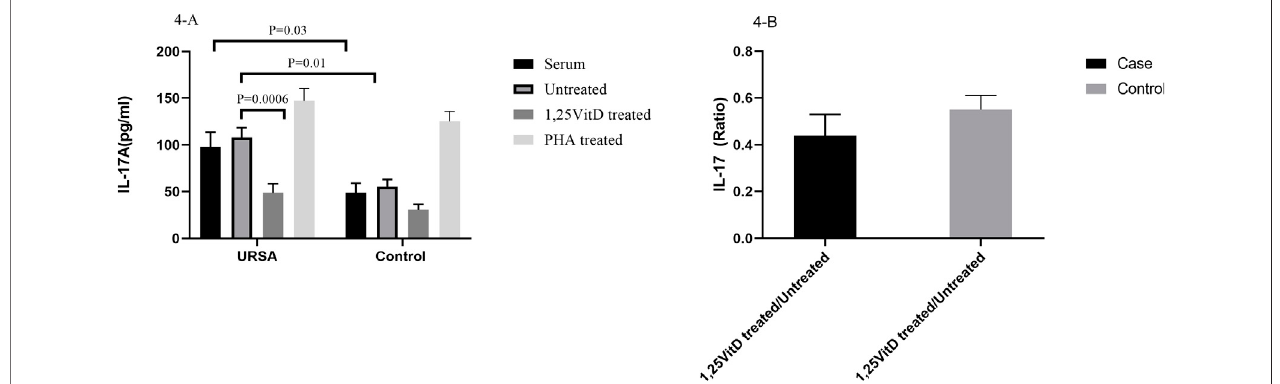
FIGURE 4 | IL-17A levels in serum and cell culture supernatants in women with URSA and the control group (A) . IL-17A serum levels signi fi cantly increased in the case groupincomparison tothecontrolgroup.IL-17Alevels signi fi cantlyincreasedinthecellculturesupernatants inthecasegroupincomparison tothecontrolgroup. IL-17A levels decreased in the presence of 1,25VitD3 compared to the absence of that in the case group. (B) . IL-17A levels non-signi fi cantly decreased in women with URSA relative to the control group.